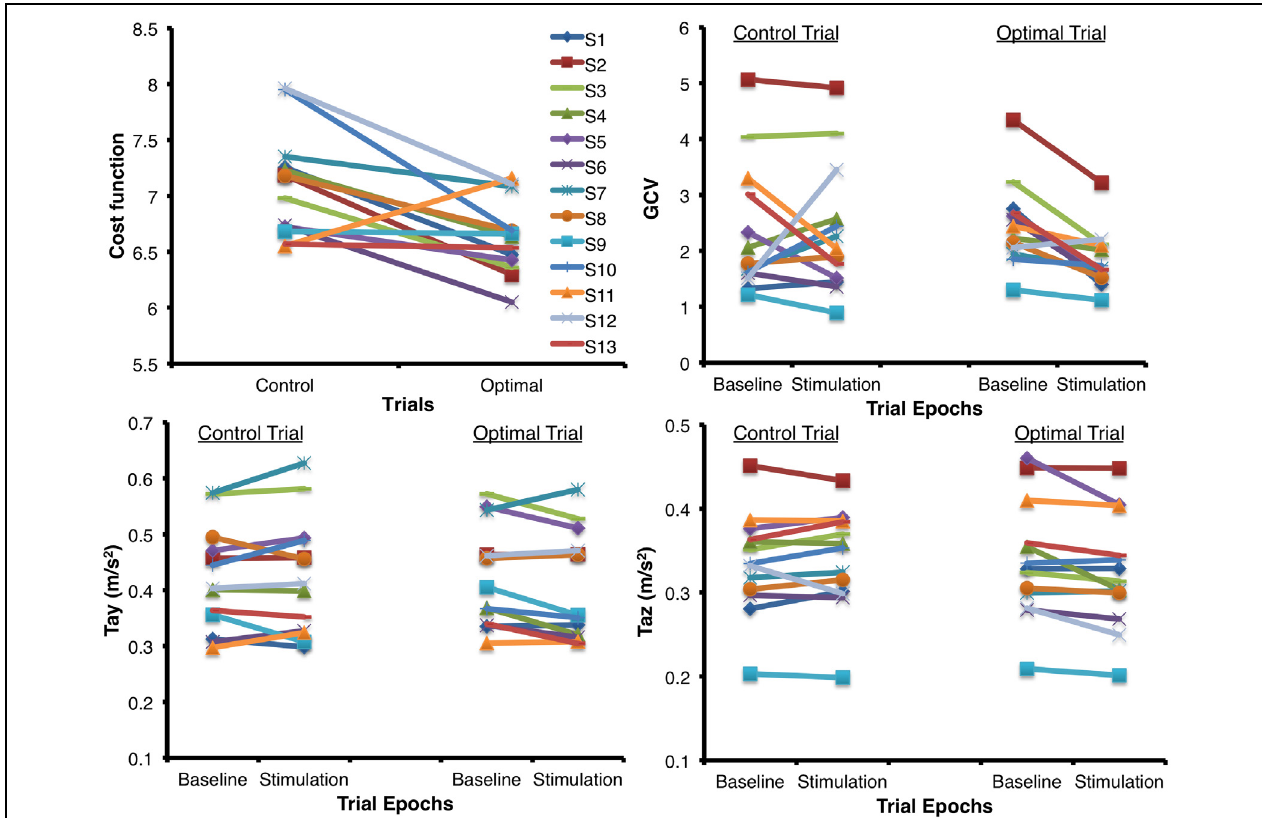
FIGURE 4 | Individual values for the cost function value calculated as the sum of ratios for the stimulus period to the baseline period across the seven parameters for the control and optimal trials as well as the individual values for the parameters GCV, Tay, and Taz that